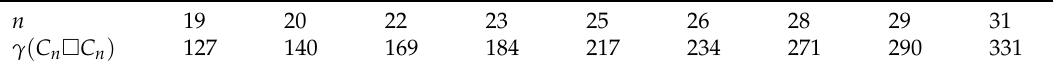
Table 1. Exact values of some square torus C n (cid:3) C n